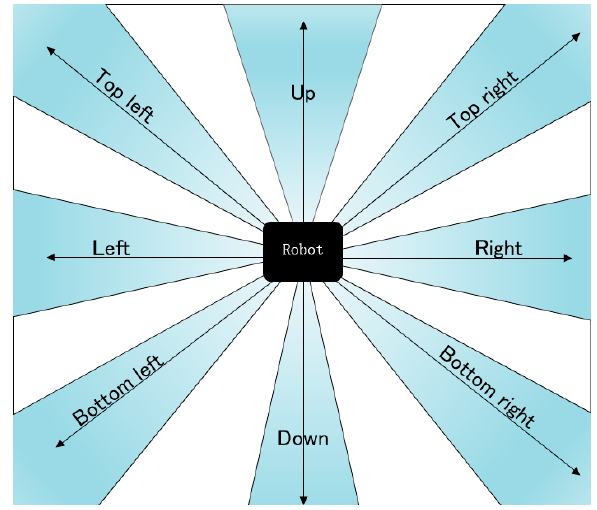
Figure 3. Schematic diagram of the eight-point scan path detection method.